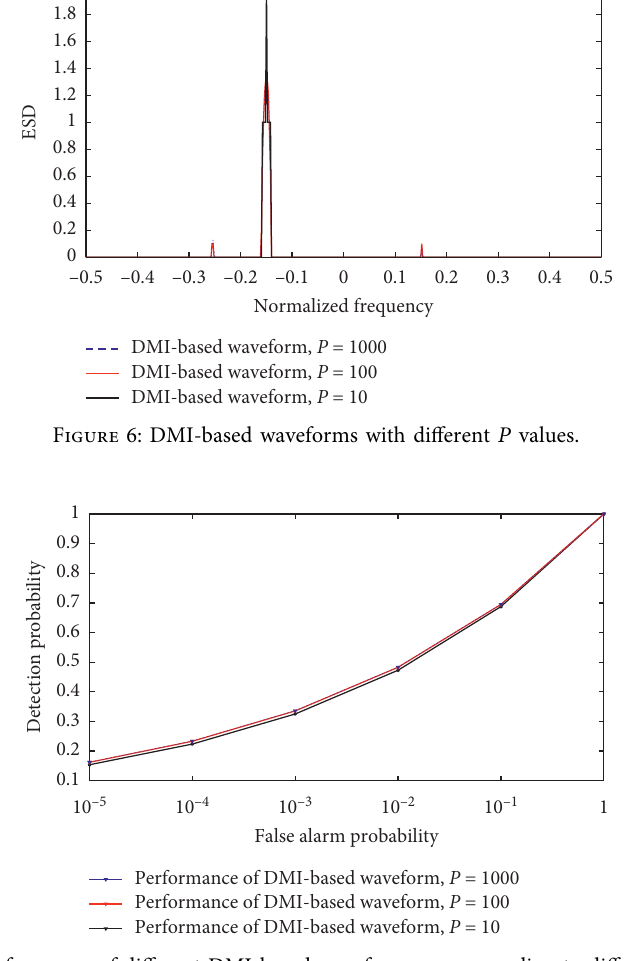
Figure 7: Performance of different DMI-based waveforms corresponding to different P values.